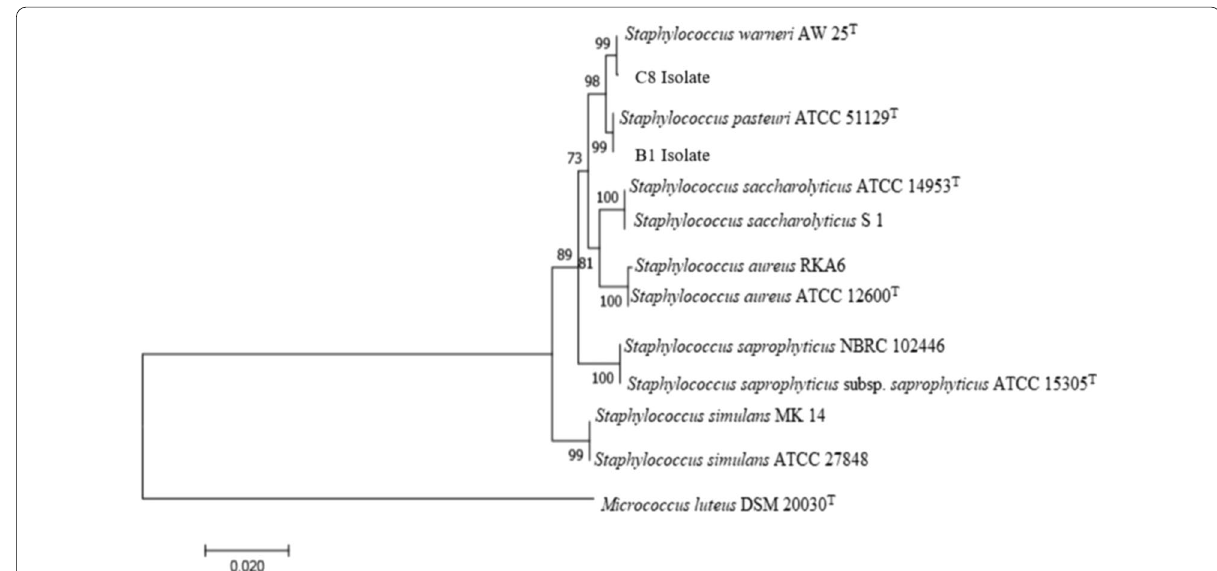
Fig. 11 Phylogenetic tree of endophytic bacterial isolates B1 and C8 with reference strains based on 16S rDNA sequence